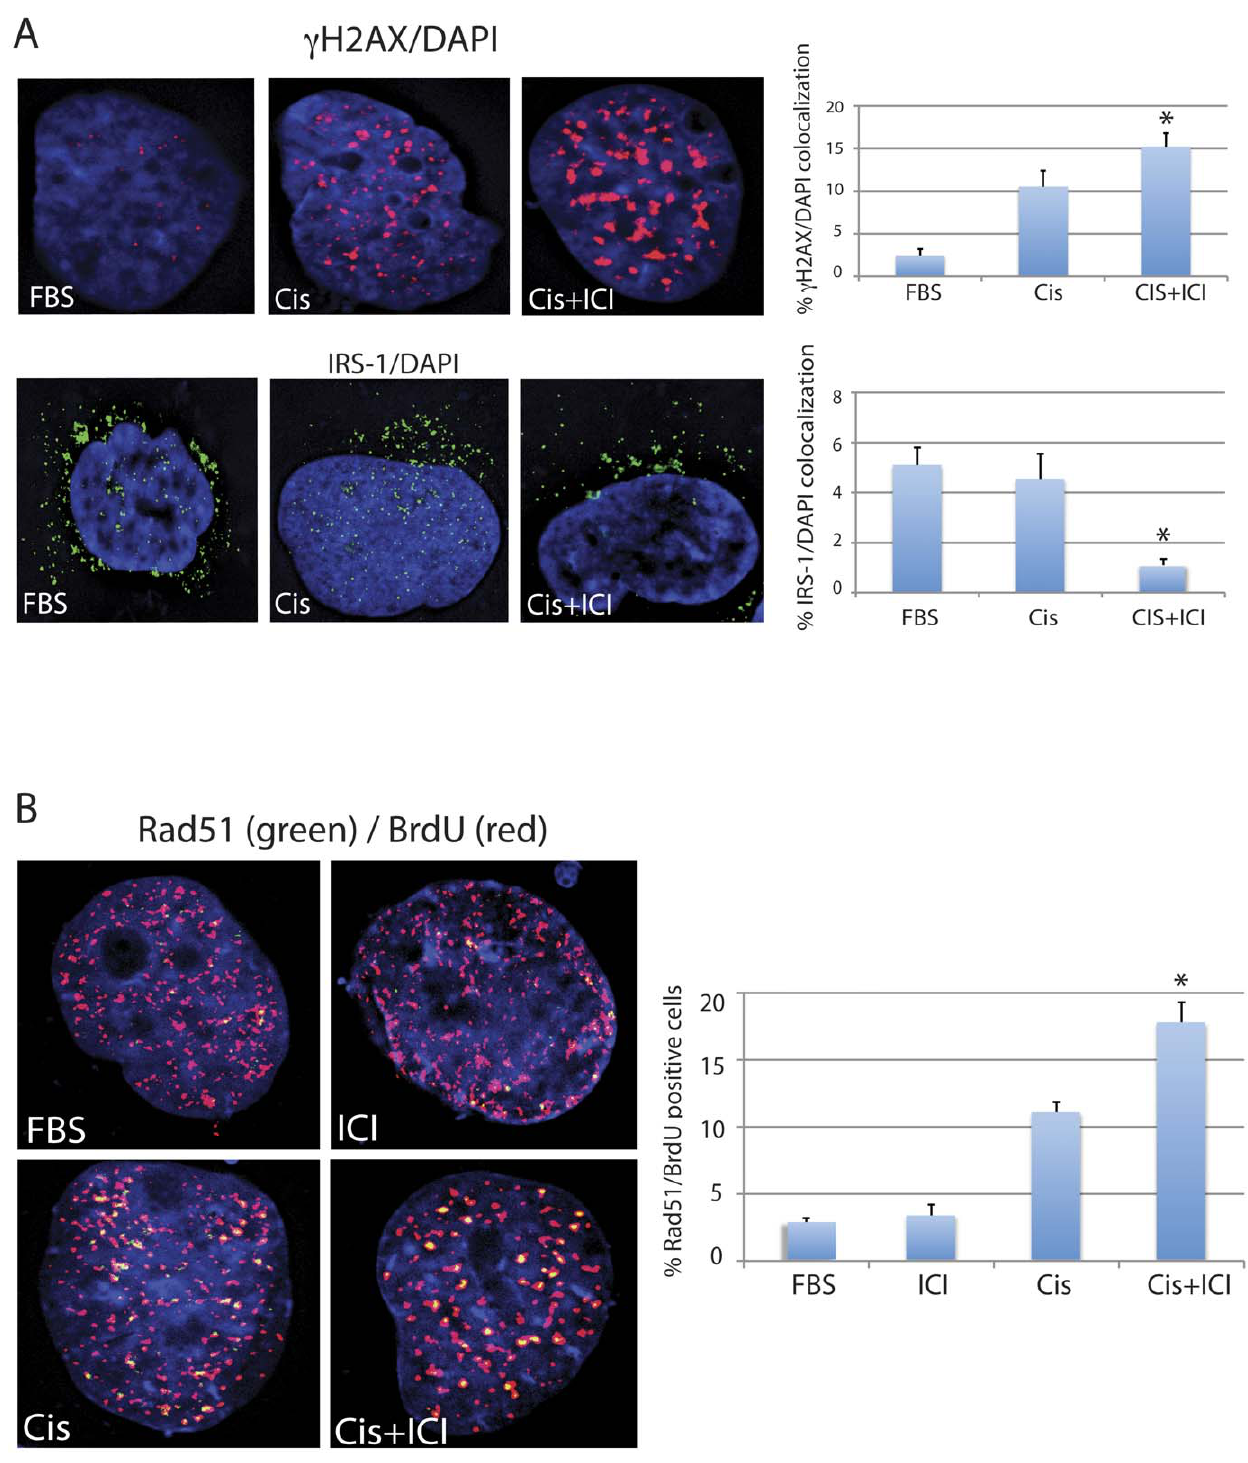
Figure 6. Inhibition of ER b activates recruitment of Rad51 during S phase DNA repair. Panel A: Fluorescent images of Daoy cells immunolabeled with anti-histone c H2AX (upper panel) and anti-IRS-1 (lower panel) antibodies. The nuclei are visualized by DAPI staining (blue fluorescence). The histograms represent quantification of the co-localization between c H2AX and DAPI; IRS-1 and DAPI. The data represent average percentage of nuclear voxels (3-D pixels) of c H2AX (red fluorescence) and IRS-1 (green fluorescence) calculated from three independent experiments (n=3) in which ten randomly selected cells have been evaluated by the Mask analysis included in SlideBook 5 deconvolution software. * indicates value statistically different from the sample labeled Cis (paired student t-test; P # 0.05). Panel B: Fluorescent images of the cells labeled with anti- Rad51 (green fluorescence) and with anti-BrdU (red fluorescence) antibodies. Exponentially growing cultures of Daoy cells (10%FBS) were exposed for one hour to bromodeoxyuridine (BrdU) during the 6 hours treatment with cisplatin (1 m g/ml) in the absence (Cis) or in the presence of 10 m M ICI182,780 (Cis + ICI). The histogram represents quantification of Rad51 positive cells in which Rad51 nuclear foci co-localize with BrdU-labeled DNA.